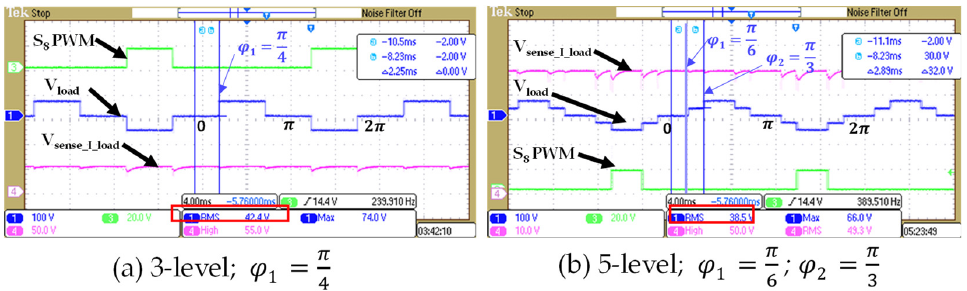
Figure 18. Experimental results—effect of increase in voltage levels.